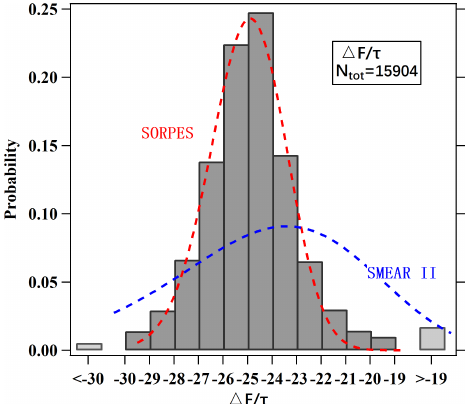
Figure 14. Probability distribution of the radiative forcing effi- ciency at SORPES (red) and at SMEAR II (blue; Virkkula et al.,